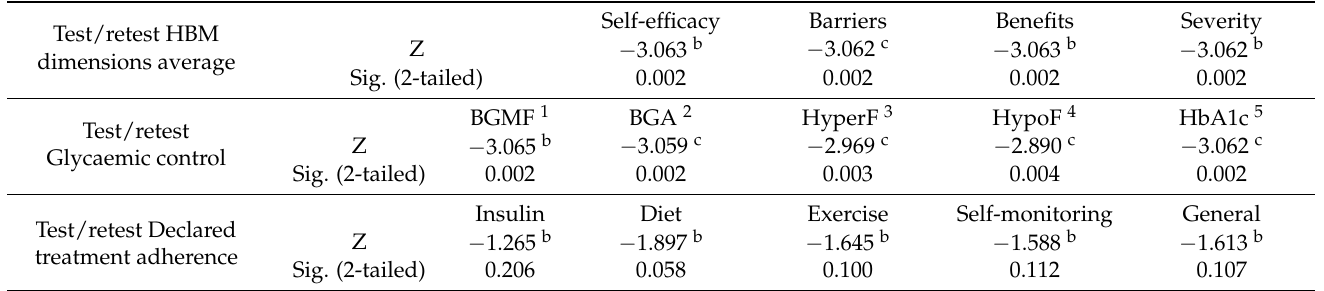
Table 4. Wilcoxon signed-rank tests for test/retest